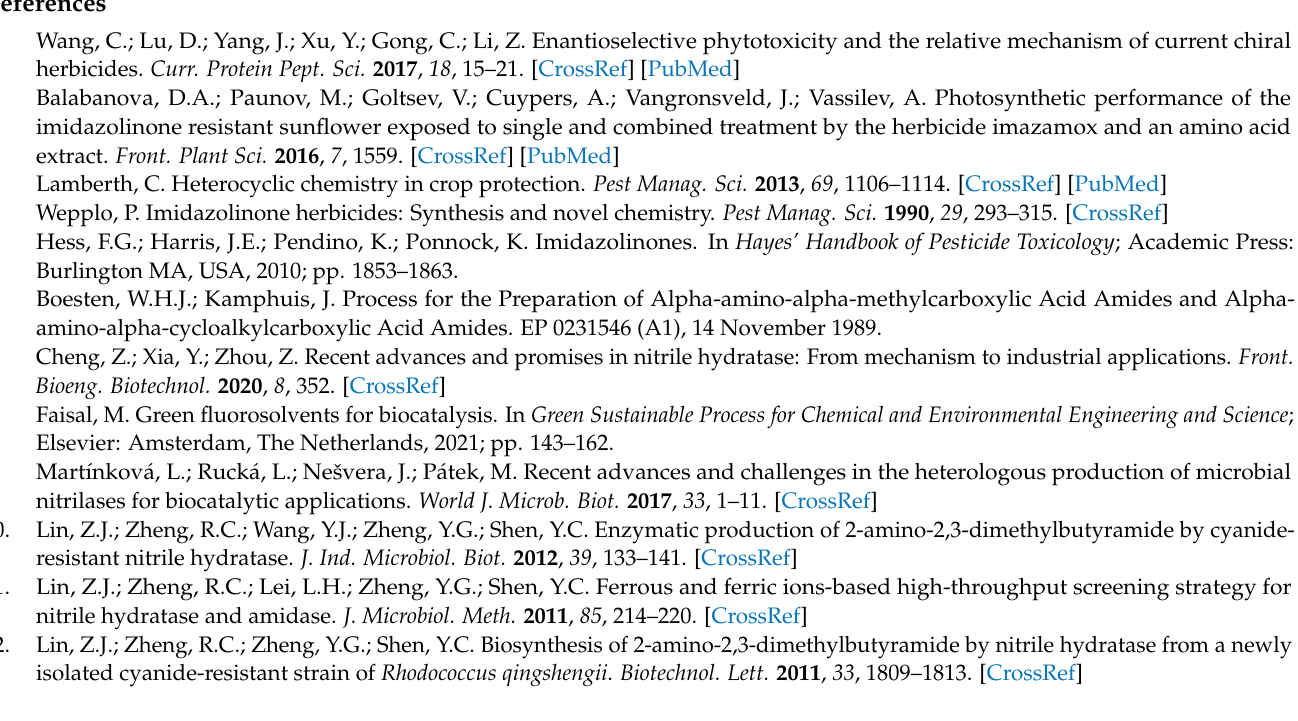
Table S2: Effect of different carbon sources on cell growth and NHase expression; Table S3: Effect of different nitrogen sources on cell growth and enzyme production; Table S4: Effect of the Angel yeast extract concentration on the growth and NHase expression of recombinant strains; Table S5: Effects of metal ions on the growth and NHase expression of recombinant strains; Table S6: Effect of induction time on cell growth and NHase expression of recombinant strains; Table S7: Effect of feeding medium on cell growth and enzyme